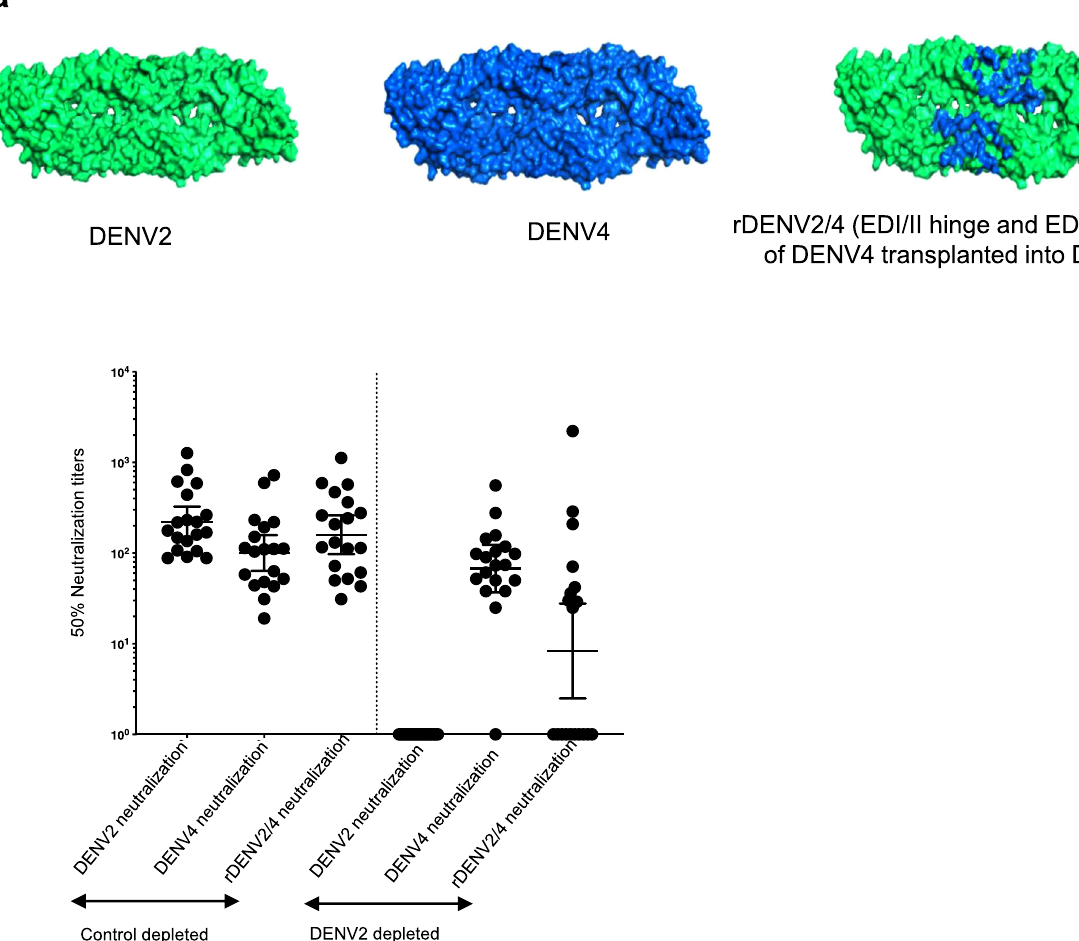
Fig. 4 TV003 induce varying levels of DENV4 serotype-speci fi c responses against known DENV4-neutralizing epitopes. a DENV2 wt (green), DENV4 wt (blue), rDENV2/4 with DENV4-speci fi c 126, 131 mAb epitopes transplanted into DENV2 (shown in blue) are depicted. b Panel of 19 sera ( n = 19) with evidence of DENV4 TS responses were subjected to depletions against DENV2 to map the DENV4 TS nAb epitopes using the rDENV2/4 virus. This is a gain of function virus. Figure shows the 50% neutralization antibody titers for the BSA depleted and the DENV2 depleted serum samples against DENV2 wt, DENV4 wt and the rDENV2/4 viruses. Data were analyzed from a total number of 19 subjects indicated as dots from a single independent experiment and expressed as geometric mean titers ± 95% con fi dence intervals of the grouped samples ( b